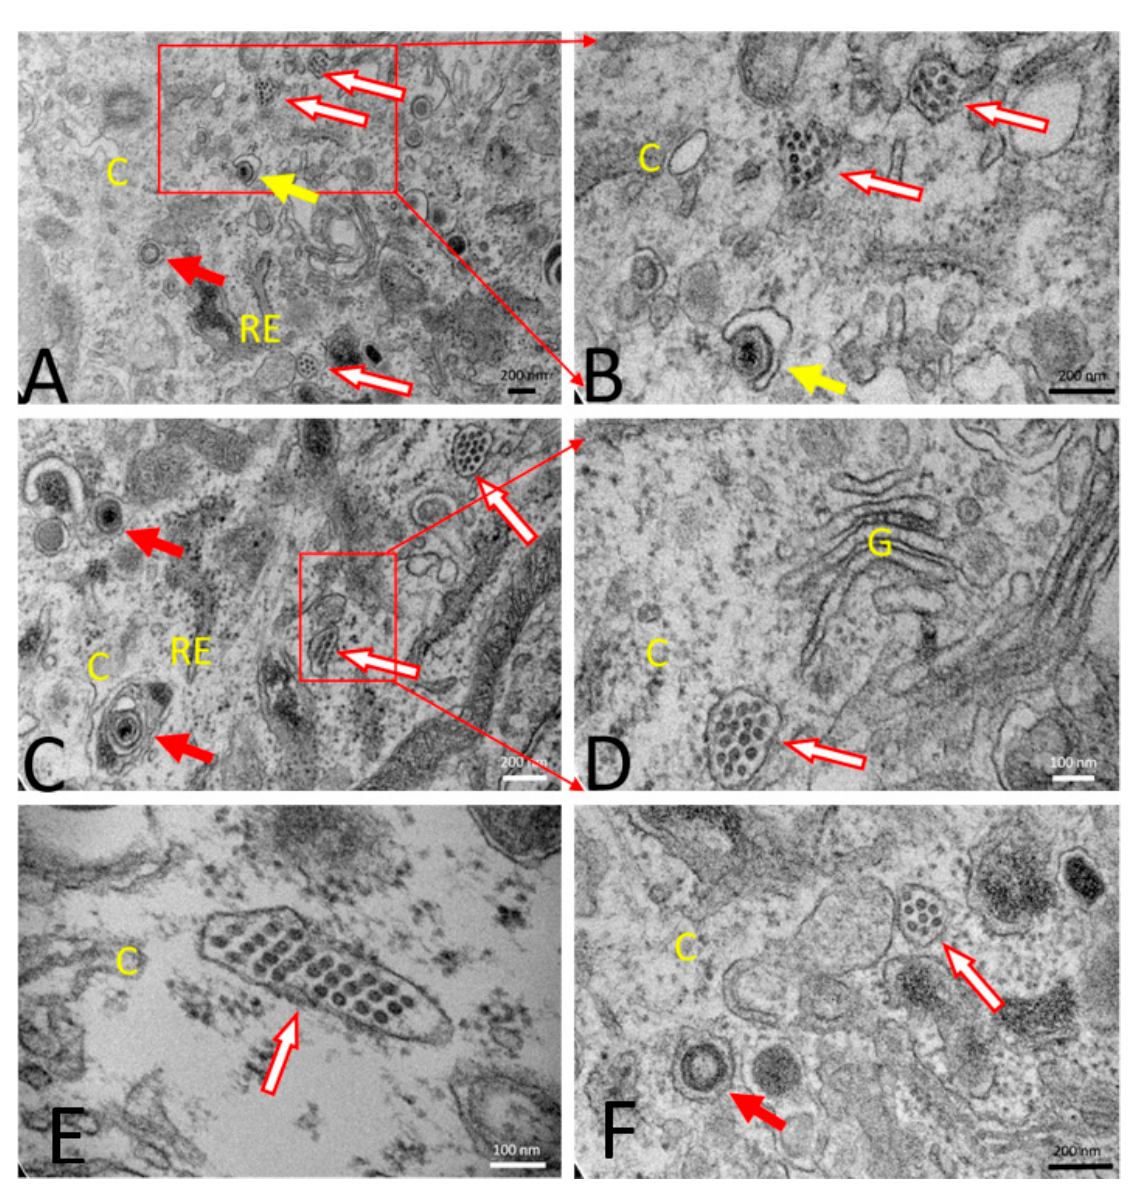
Figure 6. Transmission electron microscopy. ( A ) PRVtmv+ vaccine virus-infected swine kidney (SK) cells (infected at an MOI of 5) were fixed at 18 h post-infection. PRVtmv+ infected cells showed several fully enveloped 200 nm in diameter size PRVtmv+ vaccine virus particles in the exocytic vesicles in the cytoplasm (red arrows). Secondary envelopment of intracytoplasmic PRVtmv+ capsids by budding into vesicles was visible (yellow arrows). Most of the PRVtmv+ infected SK cells showed several accumulations of PCV2 virus ‐ like particles (VLPs) within the vesicular structures in the cytoplasm (red arrow with a white fill). The PCV2 ‐ VLPs were circular, and each measured about 20 nm in diameter. ( B ) Magnification of A is given. ( C ) The presence of enveloped PRVtmv+ vaccine virus (red arrow) and PCV2 VLPs within vesicles (red arrow with a white fill) in the cytoplasm of the PRVtmv+ infected SK cells were visible. ( D – F ) Accumulations of PCV2 ‐ VLPs within the vesicle ‐ like structures in the cytoplasm of the infected cells (red arrow with a white fill). C—Cytoplasm; RER—Rough endoplasmic reticulum; G—Golgi apparatus.